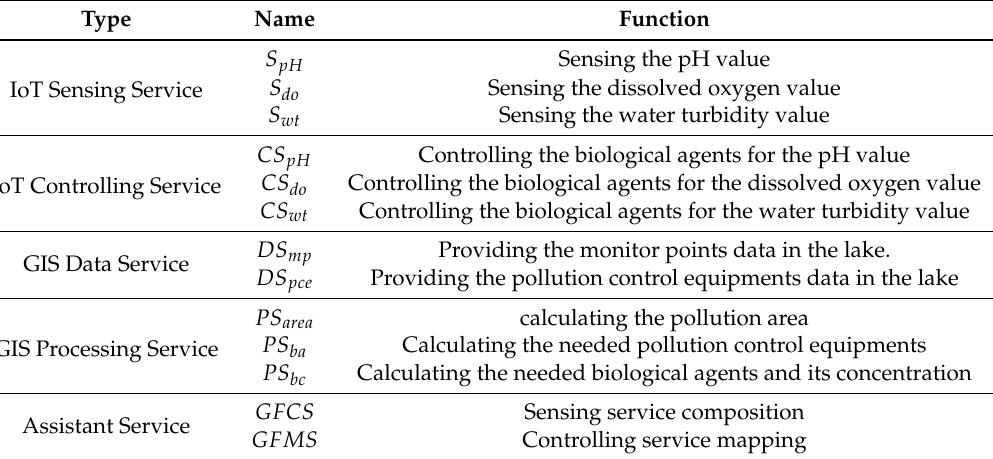
Table 5. The services in the parking lot.